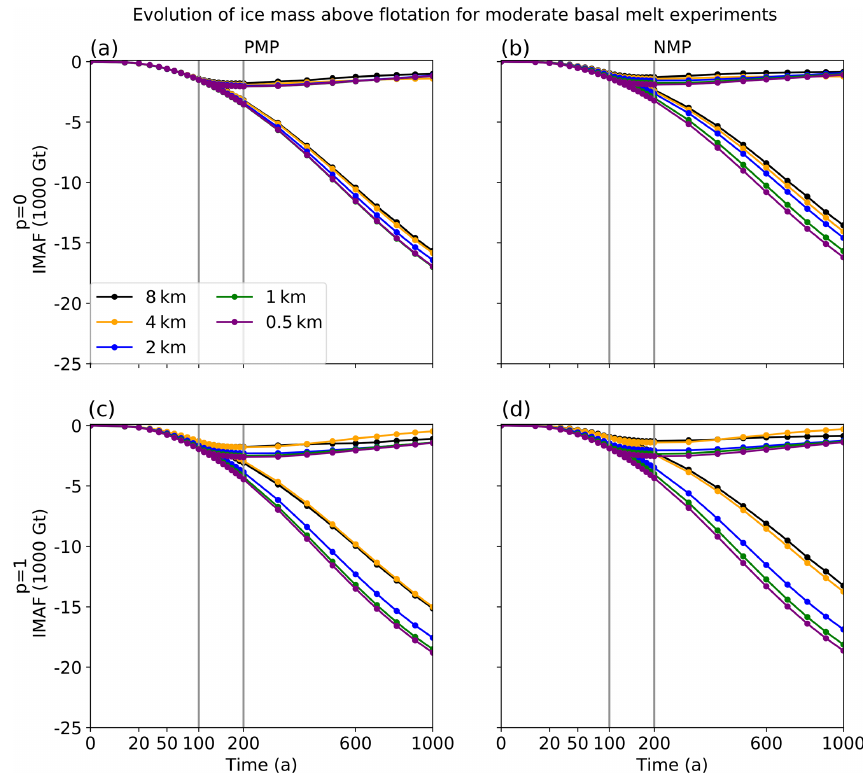
Figure 11. Evolution of IMAF relative to steady state for the full set of moderate-melt experiments. The layout is similar to Fig. 10 but showing results only for p = 0 (a, b) , p = 1 (c, d) , and melt parameterizations PMP and NMP. The vertical line at 100 years indicates the end of experiment Ice1r and the start of Ice1ra and Ice1rr. The vertical line at 200 years shows the end of Ice1ra and Ice1rr and the start of Ice1rax and